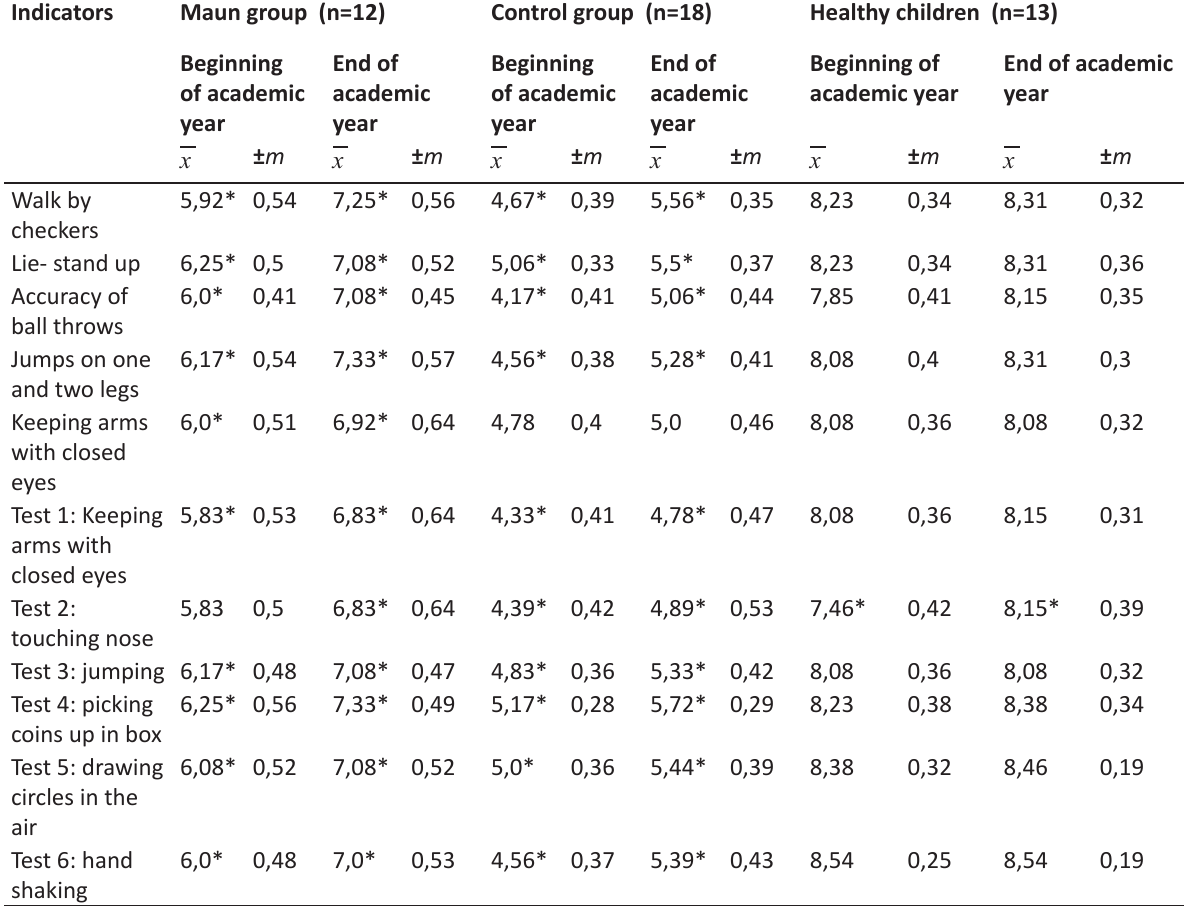
Table 2. Psycho-motor progress of 4-5 yrs healthy children and children with speech disorders Indicators